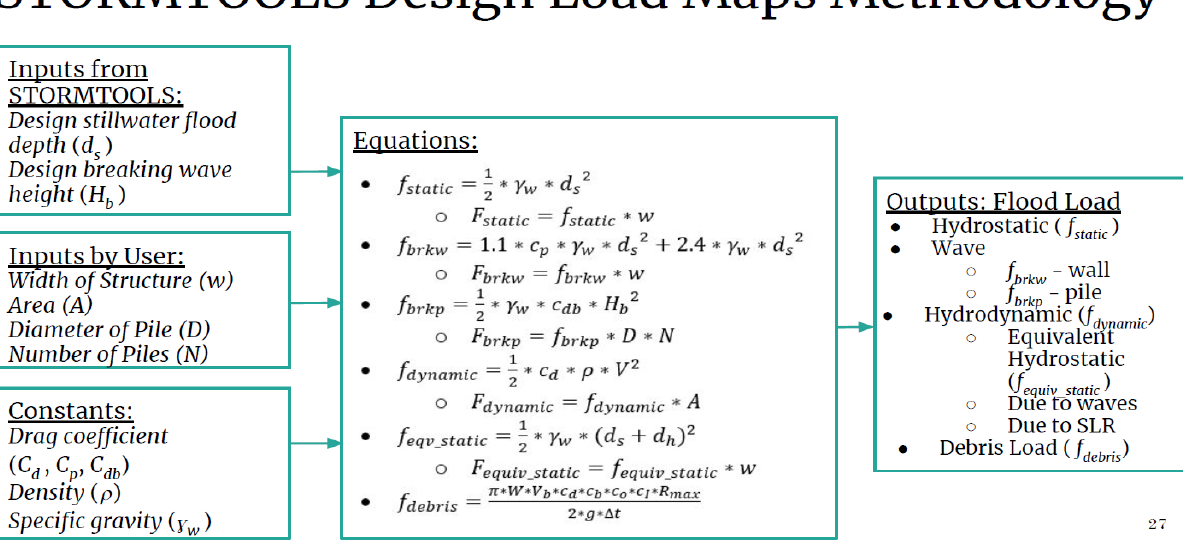
Figure 3. STORMTOOLS Design Load (SDL) methodology: inputs, governing equations, and outputs. Governing equations and explanations for each load are provided in ASCE/SEI 7–16 [9] and FEMA CCE [10] manuals.